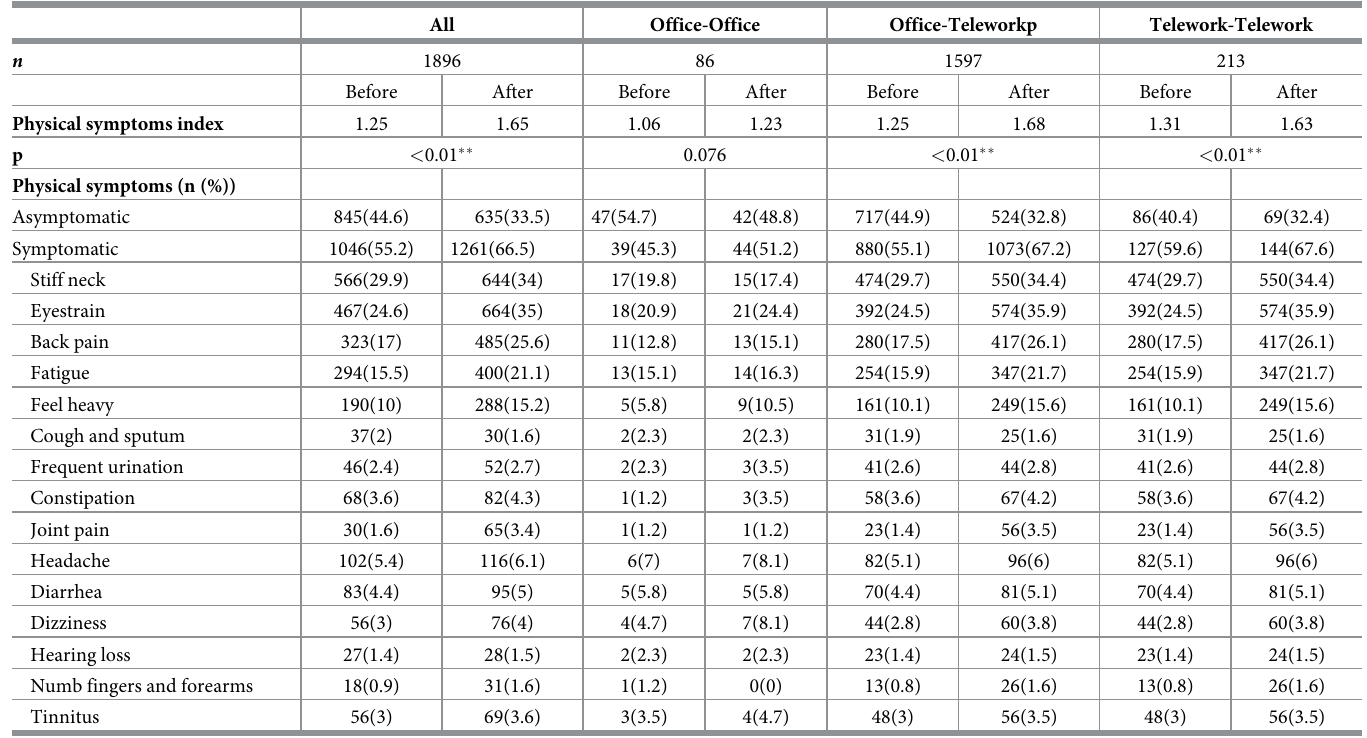
Table 5. Physical symptoms before and after the emergency declaration 1